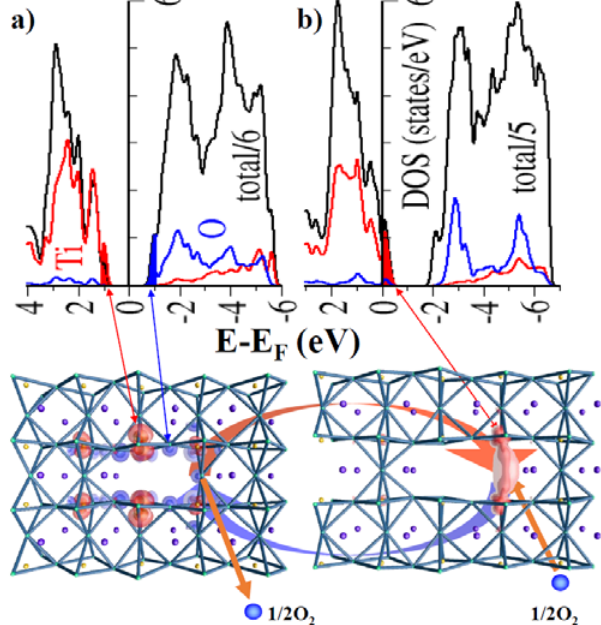
Figure 32. Ab initio calculations of the electronic structure of an extended SrO defect in SrTiO 3. ( a ) The density of states (DOS) shows a reduction of the band gap due to states near the defect. Occupied O states are shown in blue, unoccupied Ti states in red isosurfaces. Yellow, green and purple spheres represent Ti, O, and Sr atoms, respectively; ( b ) An increase of the oxygen nonstoichiometry leads to the generation of metallic state on the bottom of the conducting band. Reverse oxidation can restore the electronic structure to the semiconducting situation (blue arrow).